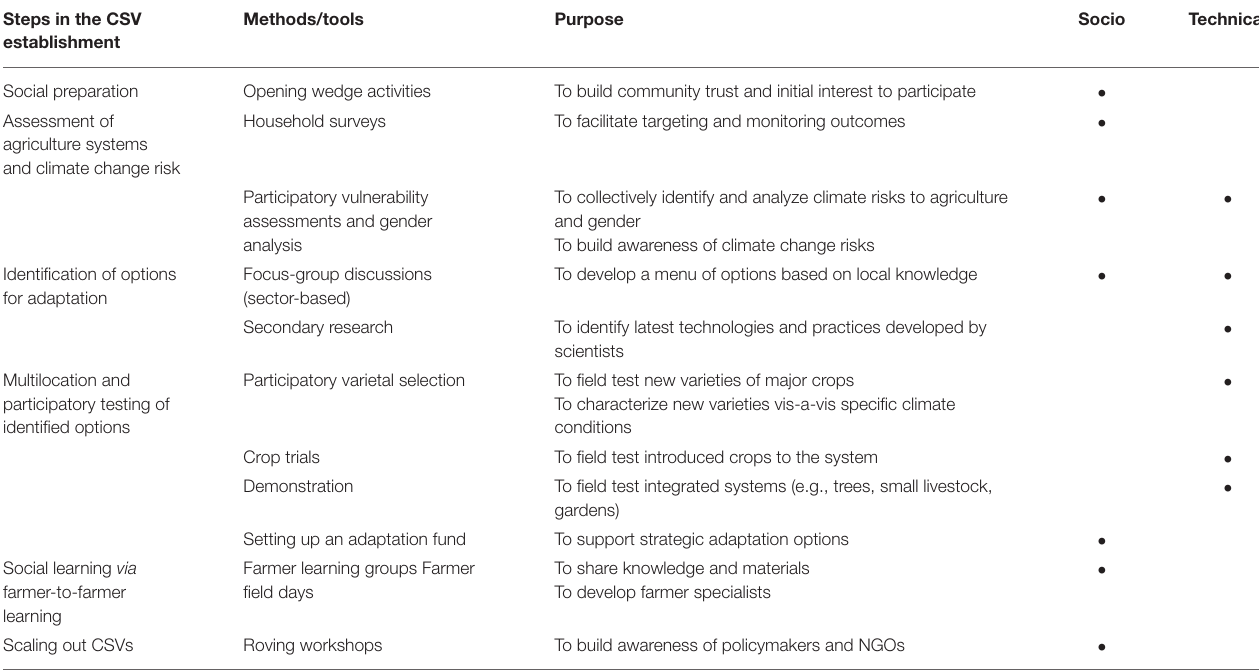
TABLE 1 | Summary of socio-technical methodologies and tools in the Myanmar